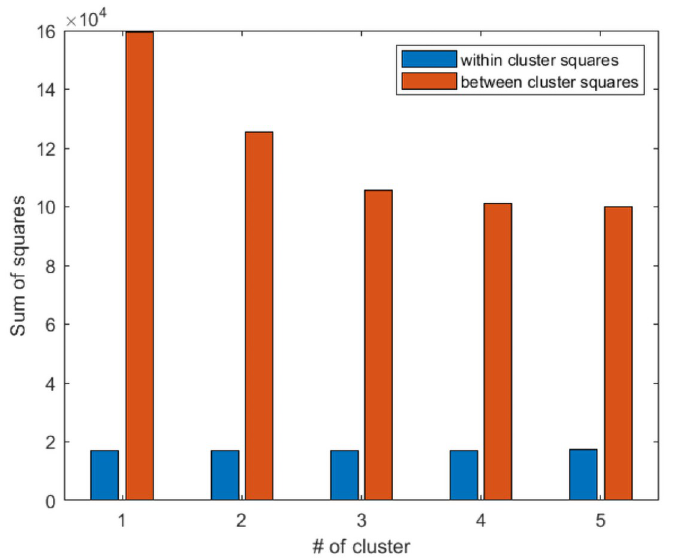
Fig 8. Sum of squares method for finding the optimal size of clusters in k-means clustering.